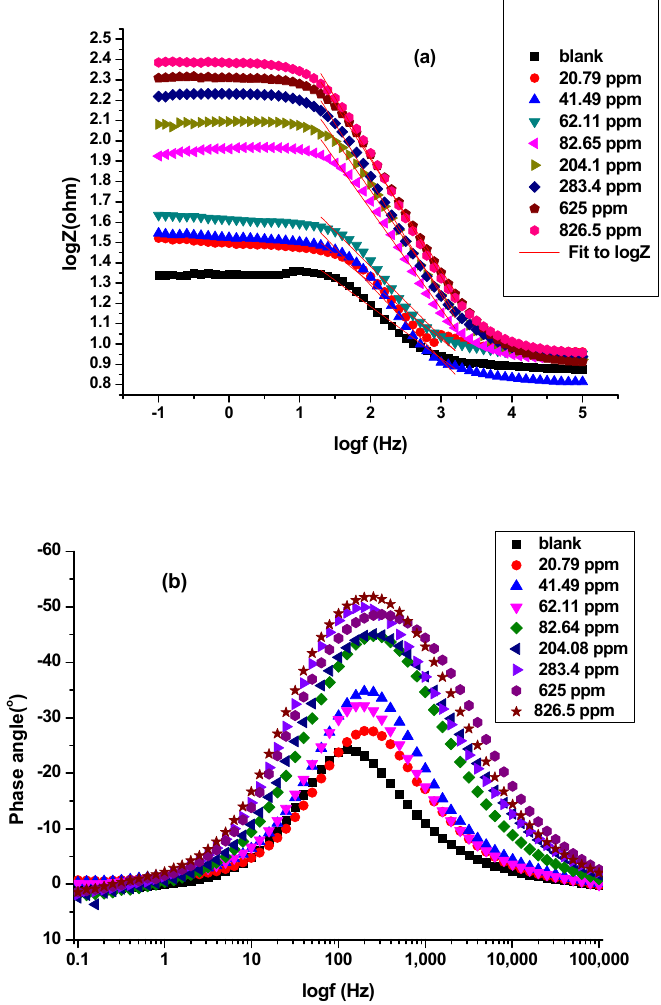
Figure 8. Bode ( a ) and Bode phase ( b ) plots of a C-steel electrode in 0.25 M H 2 SO 4 solution with and without different concentrations of Harmal extract. The α values were calculated from the slopes (red lines) of Bode plots.